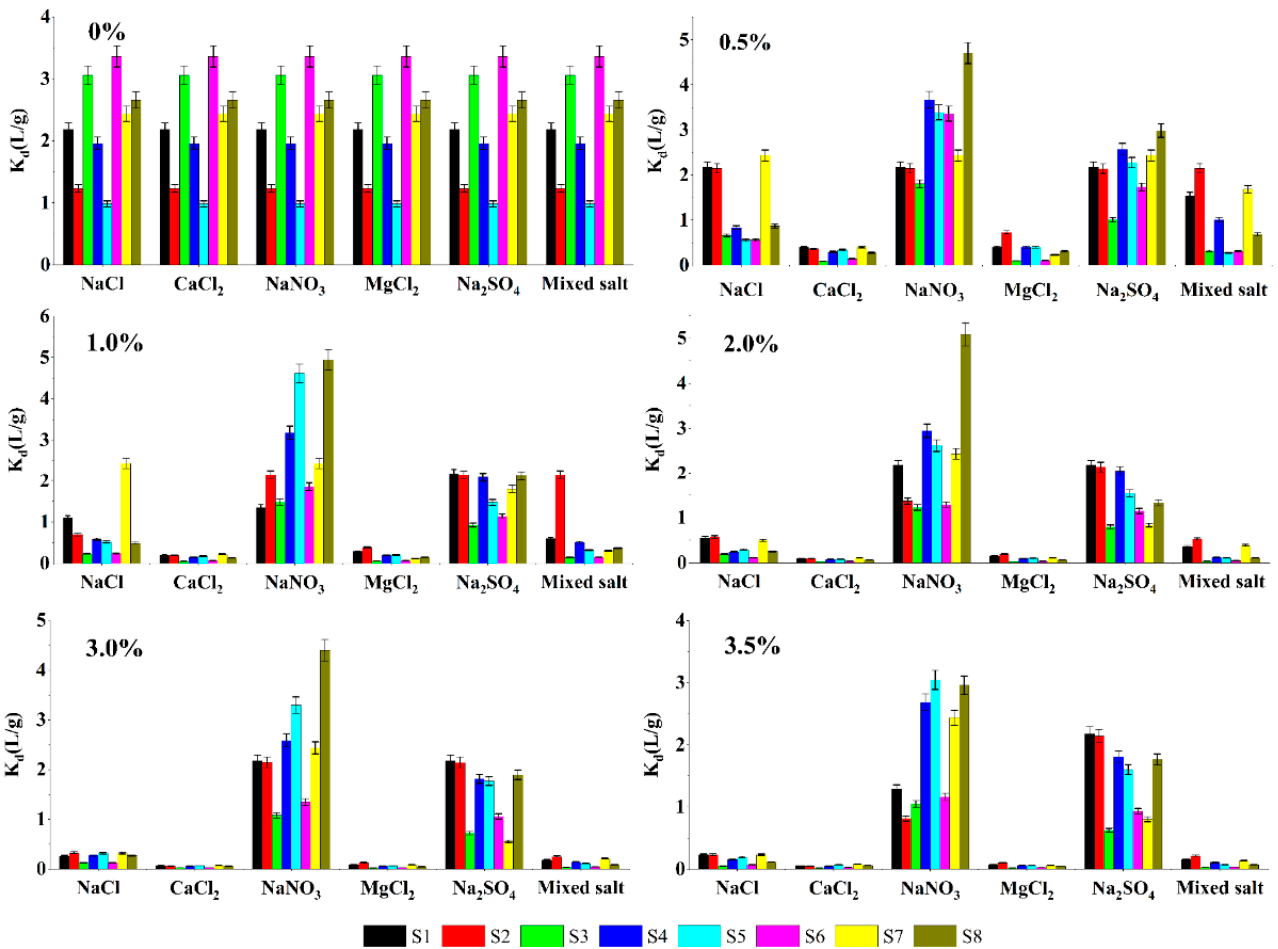
Figure 5. Kd values for Cd under different salt stresses. Vertical bars represent standard errors of the means ( n = 3). Statistically significant association ( p < 0.05).